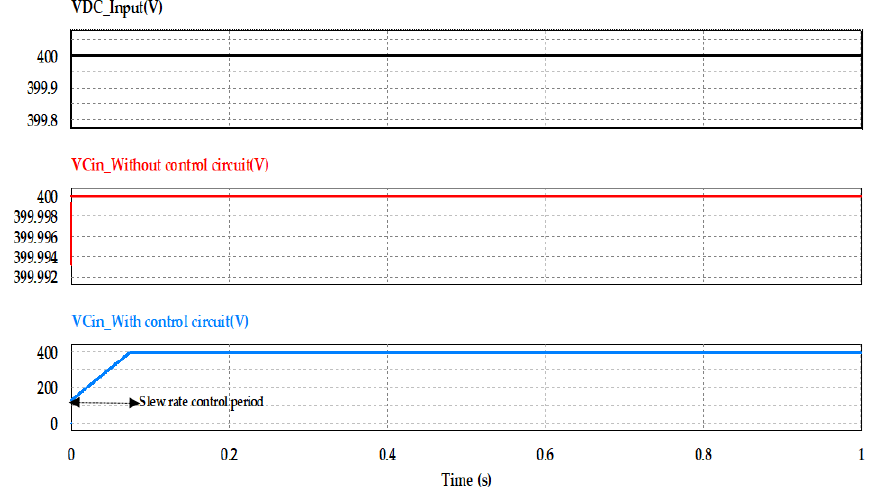
Figure 11. Bulk input capacitance charging voltage with and without using the proposed control.